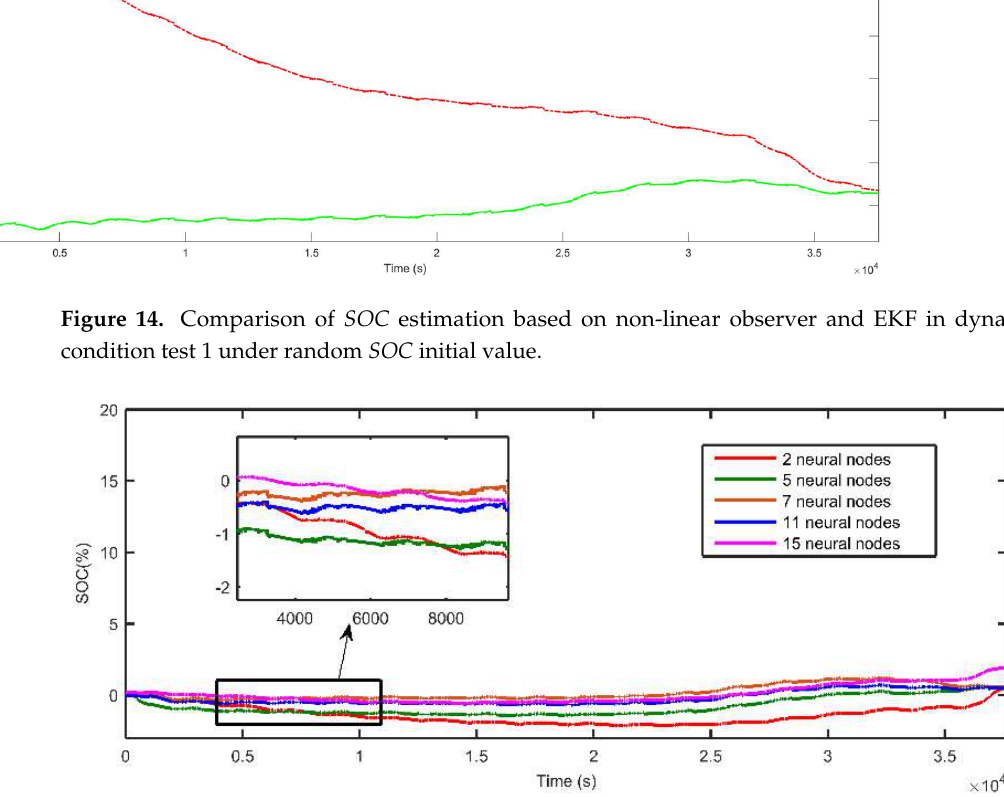
Figure 15. SOC estimation error of non-linear observers with different numbers of neural nodes.